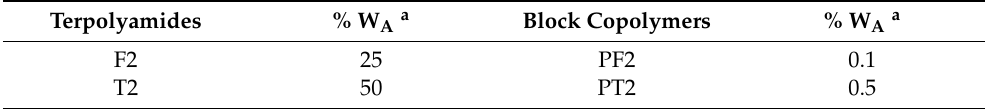
Table 3. Water absorption data of the selected terpolyamides and their block copolymers. Terpolyamides